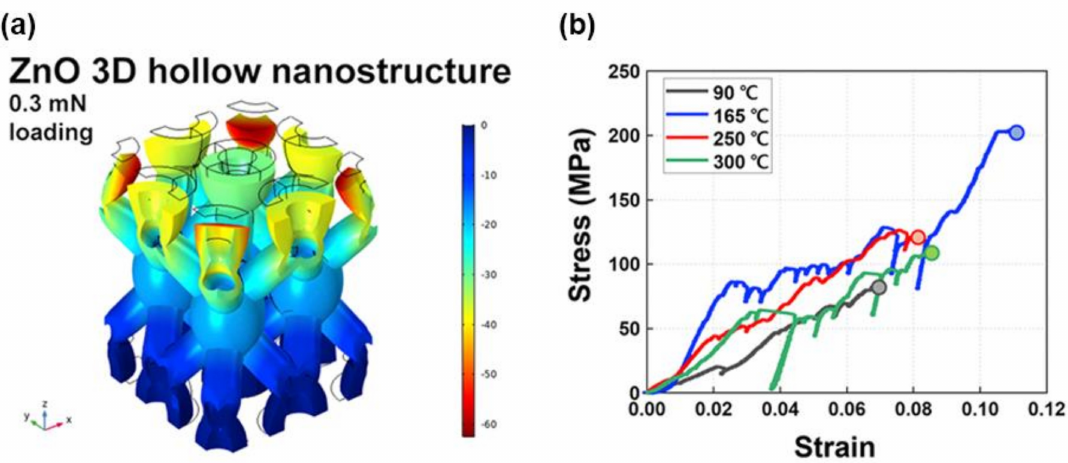
Figure 7. Simulation results: ( a ) FEA simulation of 3D ZnO nanostructure [113]; ( b ) stress − strain plot of compression tests [113]. Reproduced with permission, Copyright 2020, Nano